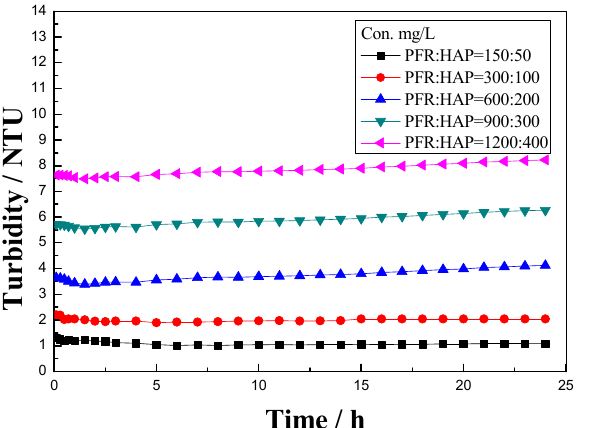
Figure 6. Effect of HAP on the turbidity of PFR prepared with simulated injection water at 25 °C .